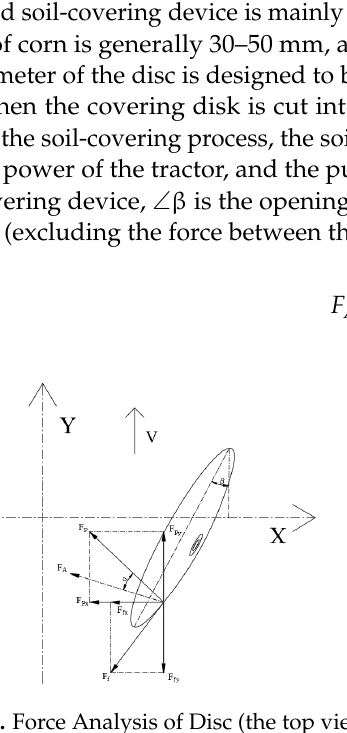
Figure 5. Force Analysis of Disc (the top view).